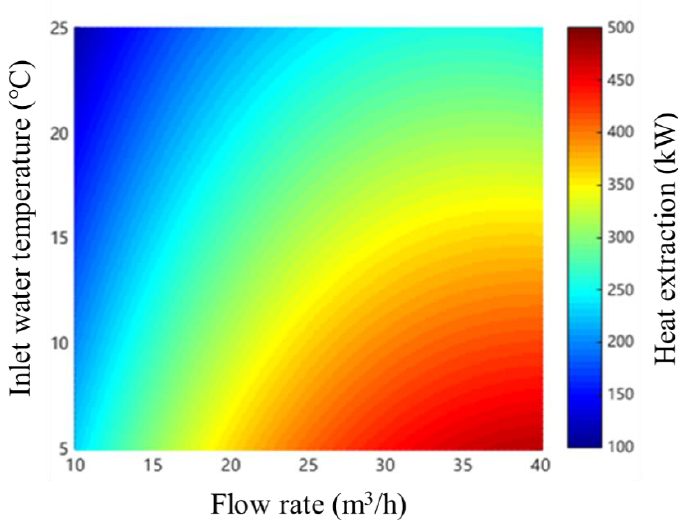
Figure 25. Effect of inlet water temperature and flow rate on the heat